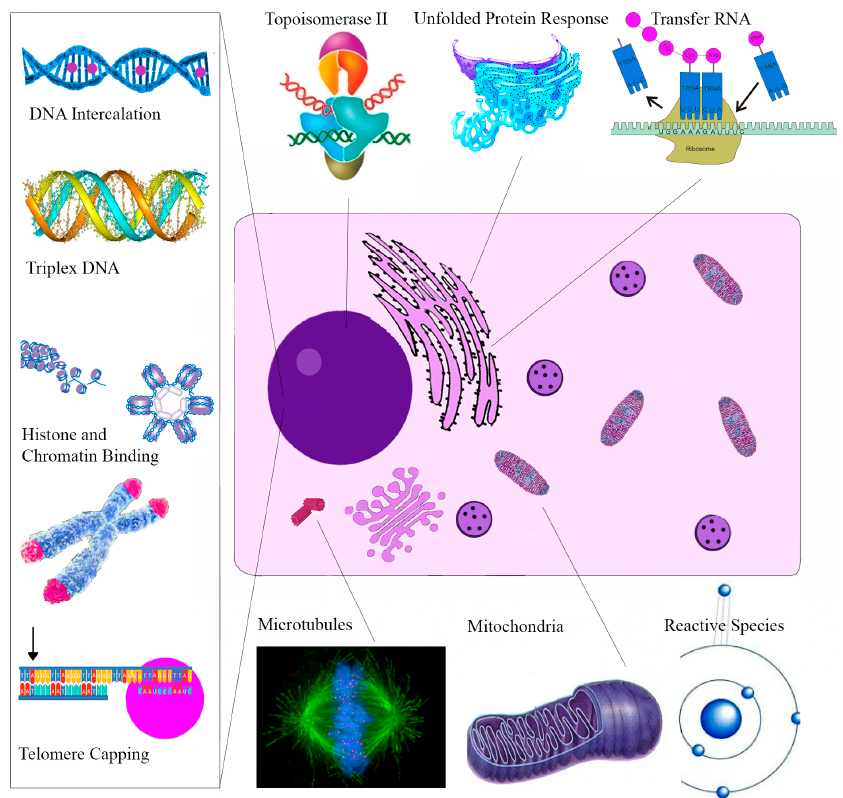
Figure 3. The cellular targets of sanguinarine. This figure highlights the variety of cellular organelles and molecular processes disrupted by sanguinarine. The only sanguinarine molecules (purple dots) in the diagram are represented in the DNA Intercalation